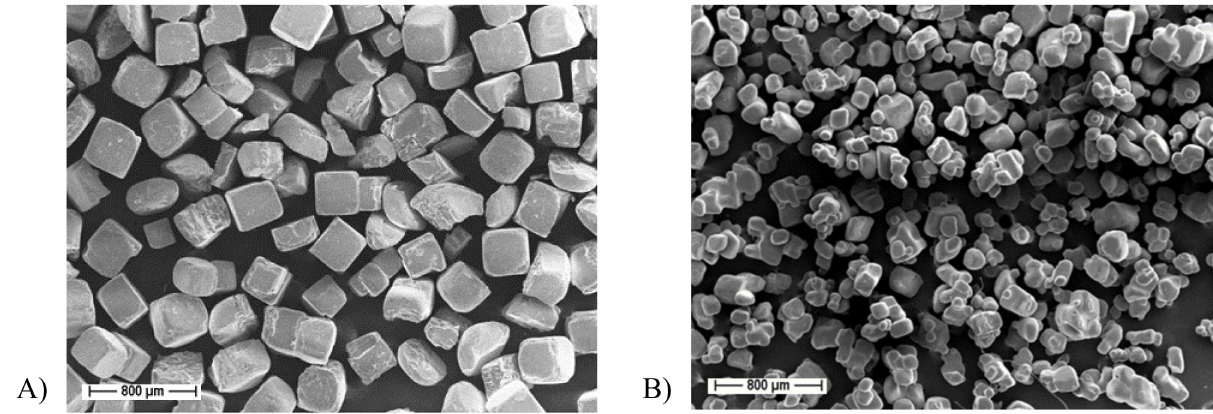
Figure 13. FESEM micrographs of commercial NaCl ( A ) and NaNO 3 ( B ) salts, used as pore formers to prepare the